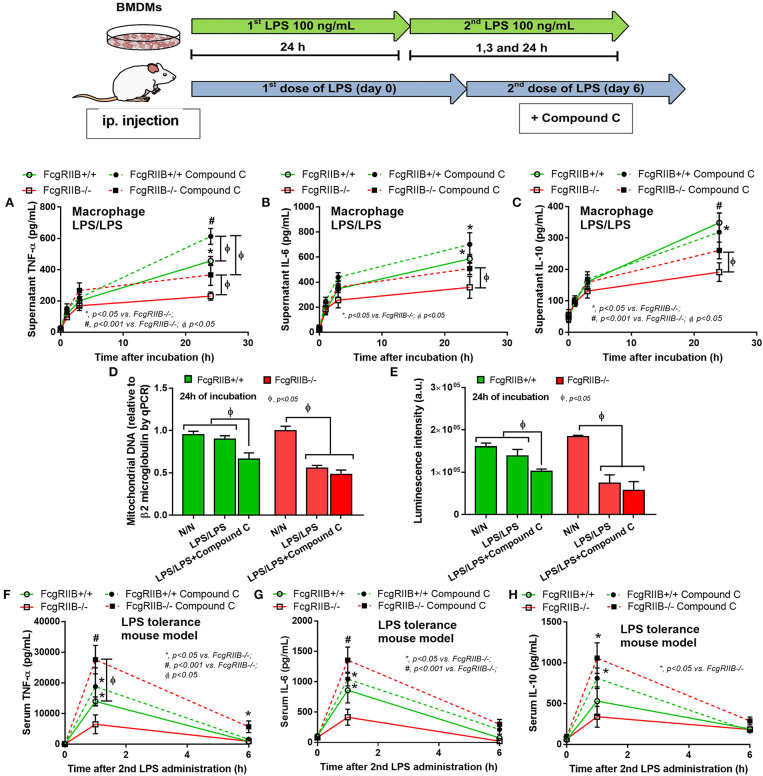
Schematic diagram of the experiment with LPS-tolerance induction (LPS/LPS) in macrophages and LPS injection in mice are shown (upper part). Supernatant cytokines of LPS-tolerant FcgRIIB–/– macrophages and wild-type (FcgRIIB+/+) with or without compound C (AMPK inhibitor) (A–C), semi-quantitative expression of mitochondrial DNA content (mtDNA) relative to β2 microglobulin (β2M) gene by qRT-PCR (D), and luminescence intensity of cellular ATP production (E) are demonstrated (independent triplicate experiments were performed). Serum cytokine from FcgRIIB–/– and wild-type mice after LPS-tolerance induction with placebo control or compound C treatment (F–H) are shown (n = 6–7/group). BMDMs, bone marrow-derived macrophages.